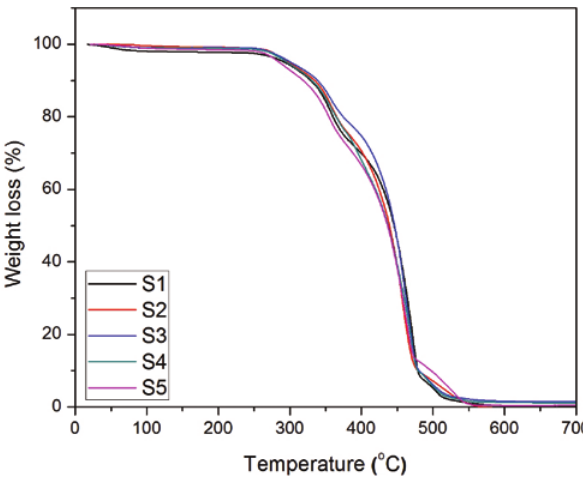
Figure 13: TGA curves of the composites.